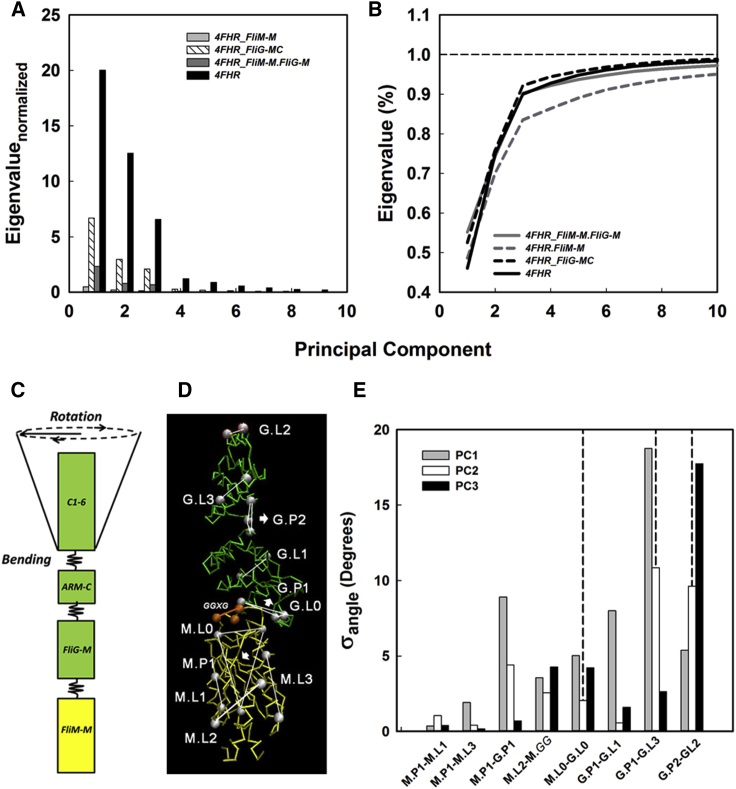
PCA of the FliMMFliGMC Complex(A) Eigenvalues for the first ten PCs of the ensembles normalized by the sum of the FliMM (gray) eigenvalues.(B) Cumulative spectra (lines) show the anisotropy of FliMM motions is increased in complex with FliGM (dark gray line) or FliMMFliGMC (black line) than when alone (dashed gray line). The anisotropy of FliMMC (dashed black line) motions is not affected by complex formation.(C) Schematic of the complex as a segmented rod with intervening hinges. FliMM (gold), FliGMC (green).(D) Vectors (white lines) used for measurement of hinge and interfacial motions. White spheres mark Cα atoms of connected residues. White arrows show perpendiculars to the chosen planes (triangles). Orange vector (line) marks GGPG motif (spheres).(E) First three PC amplitudes between vector pairs measured as the σ of the difference angle distributions. Bending = MP1.ML1, MP1.ML3, MP1.GP1, GP1.GL1, GP1.GL3. Rotation = ML2.MGG, ML0.GL0, GP2.GL2. Dashed line separates FliMM and FliGMC pairs. Vector labels are as in (D).